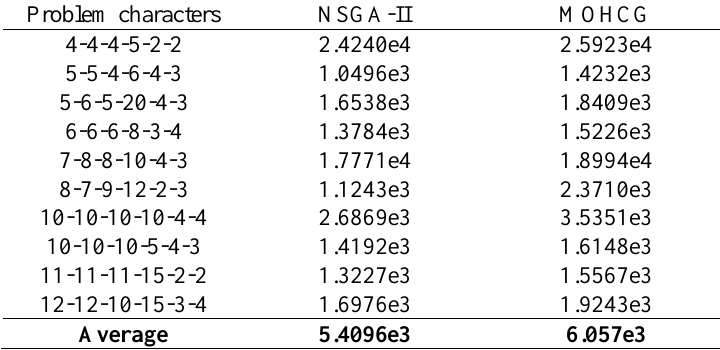
Table 5 . DM measure for small sized instances Problem characters